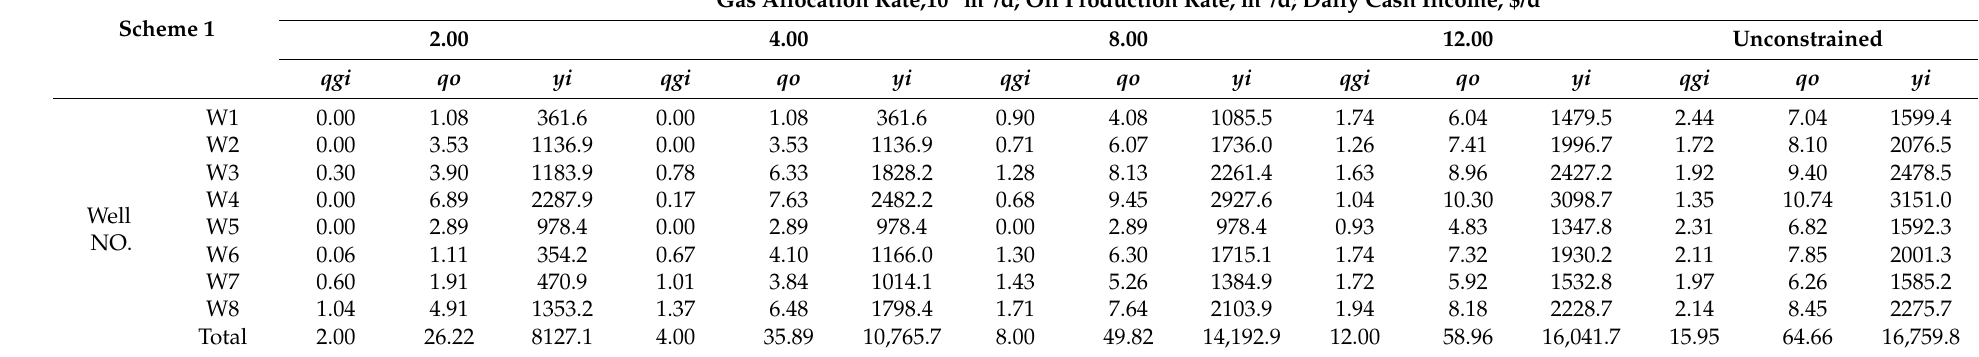
Table 8. Gas allocation results of various injected gas rate of Scheme 1.